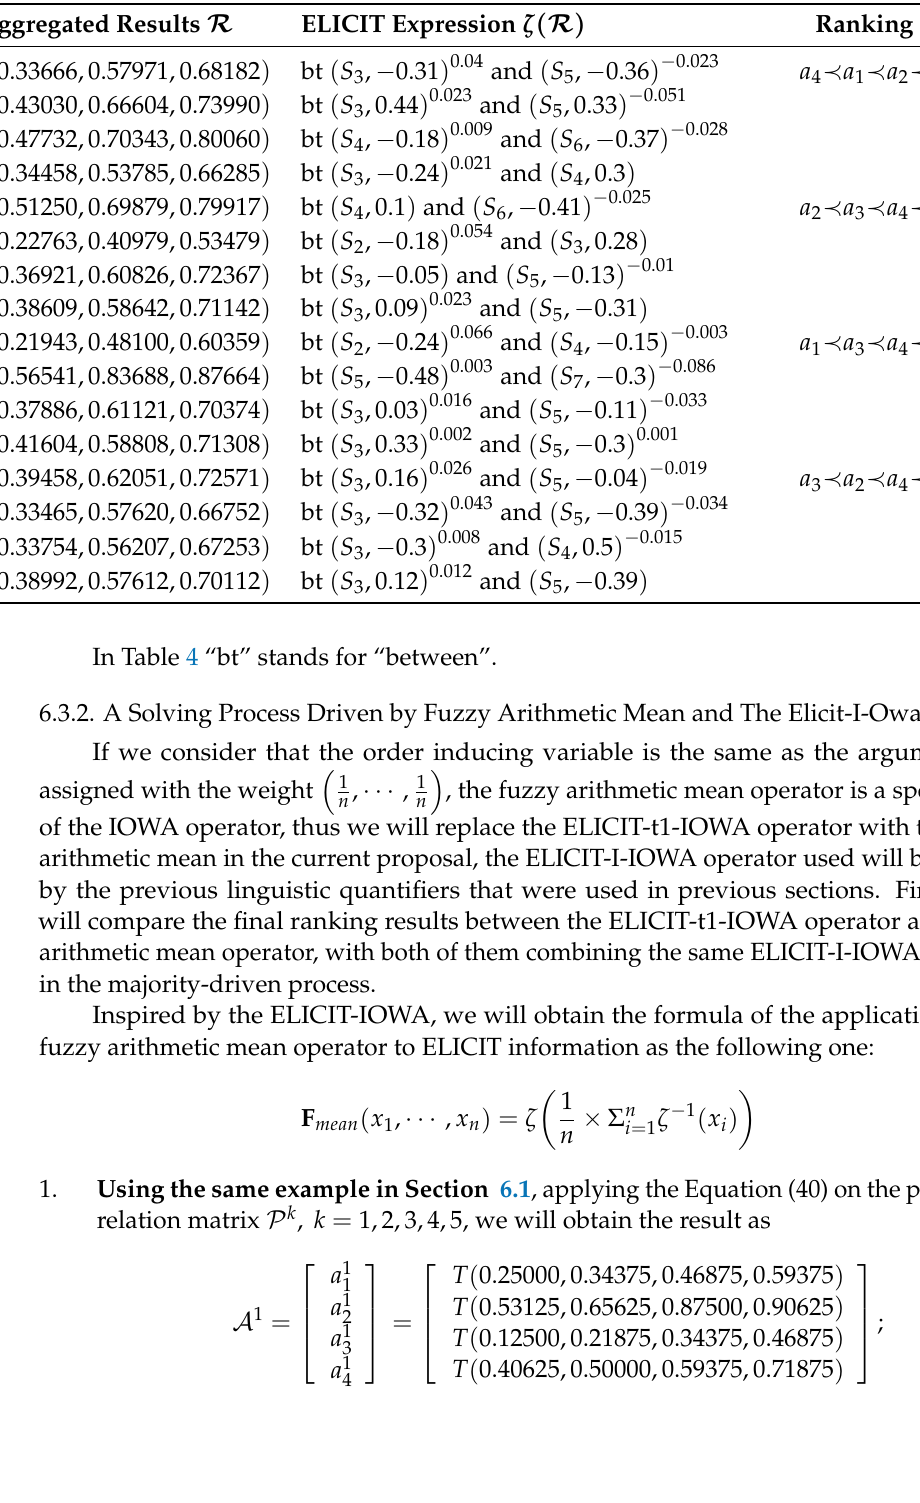
Table 4. The overall result with ELICIT